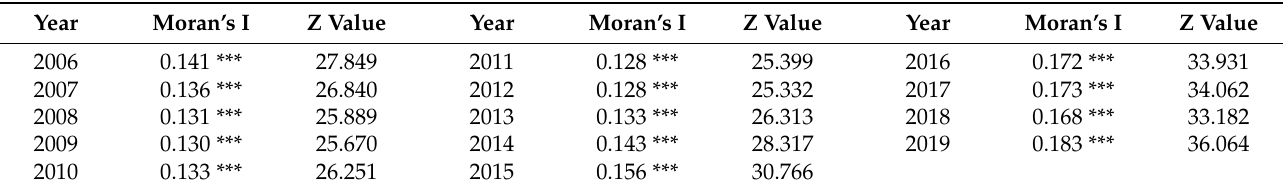
Table 9. Results of spatial correlation